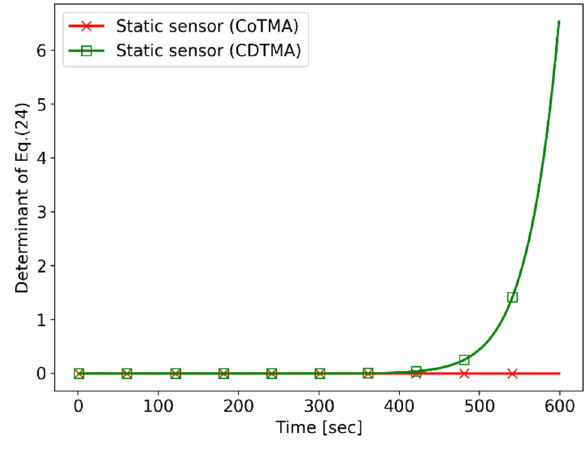
Figure 13. Simulation II: performance index (static sensor scenario).